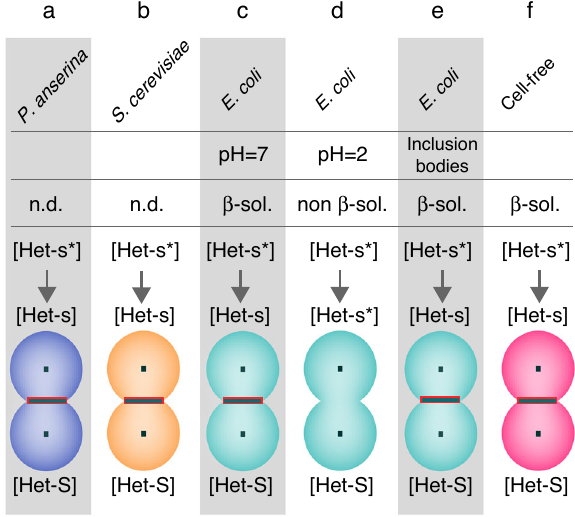
Fig. 4 Infectivity of the prion-forming domain of HET-s from various cell culture and assembly conditions. Summary of the infectivity of HET-s (218-289) aggregates depending on the culture and assembly conditions. a , b HET-s expressed in P. anserina and S. cerevisiae from refs. 80, 114. c , d HET-s aggregates puri fi ed from an E. coli expression and assembled at pH = 7 84 and pH = 2 11,71 . e HET-s aggregates extracted from E. coli inclusion bodies from ref. 79. f HET-s assembled in the CF reaction mixture from this work. High-resolution structures for ( a and b ) are unknown. c , e , f aggregates present a β -solenoid fi brillar structure. d aggregates are not β -solenoid. a – c , e , f aggregates are infectious, they induce the conversion of [Het-s*] non-prion strains to prion-infected in [Het-s] strains that produce a barrage reaction to [Het-S]. d aggregates are not